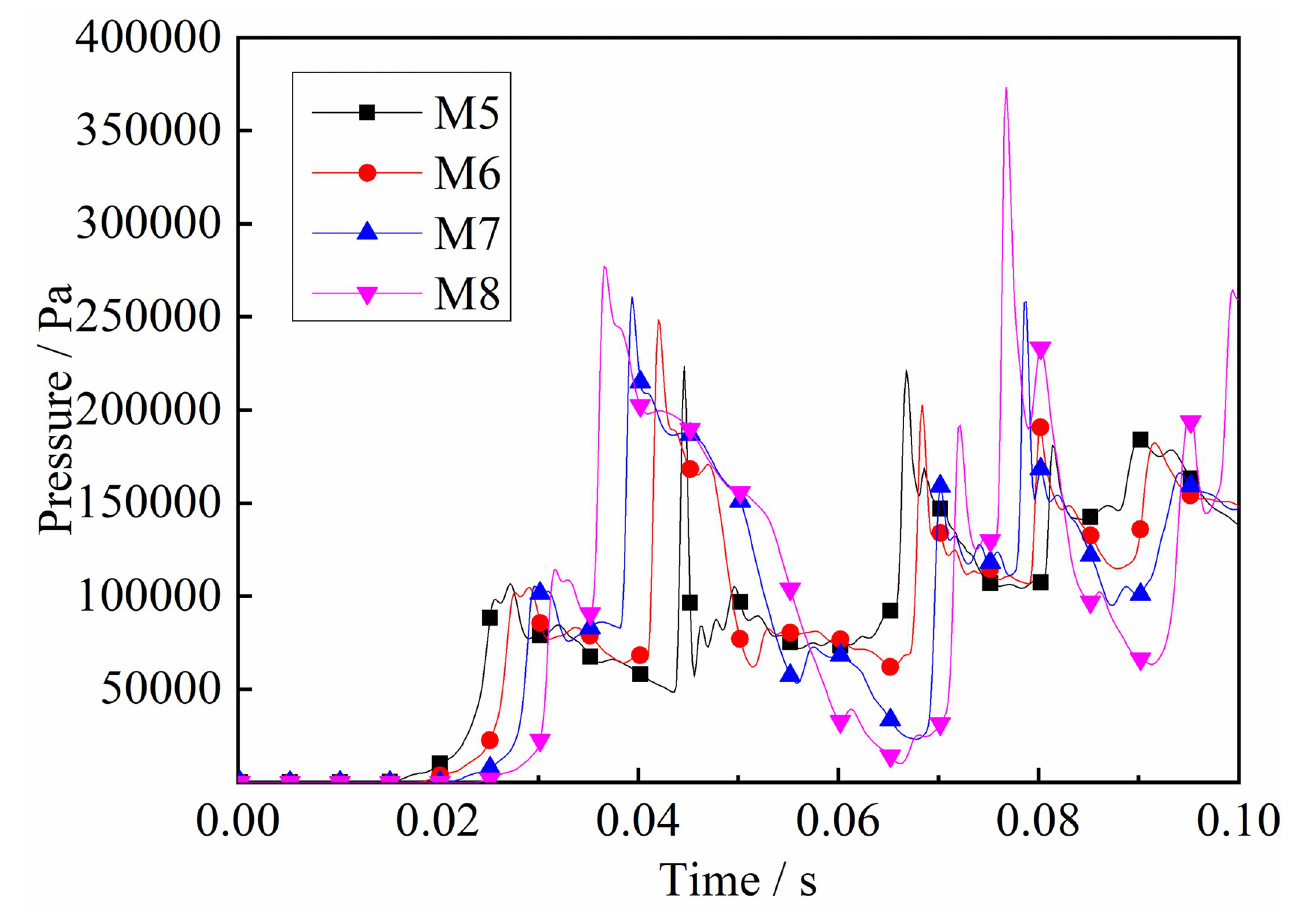
Fig 13. Pressure—Time curves at the monitoring point M5-M8 (gas concentrations 9.5%).